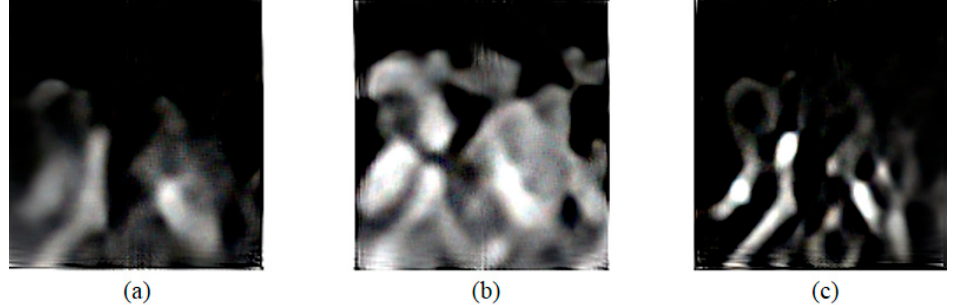
Figure 5. Locally magnified (10 times) microvascular images of rabbit kidney using: ( a ) Gaussian PSF deconvolution + scatter plot, ( b ) High-order moment calculation + power Doppler integration, and ( c ) Integral form of Gaussian PSF deconvolution + ASH respectively. All images are shown with a dynamic range of 50 dB.